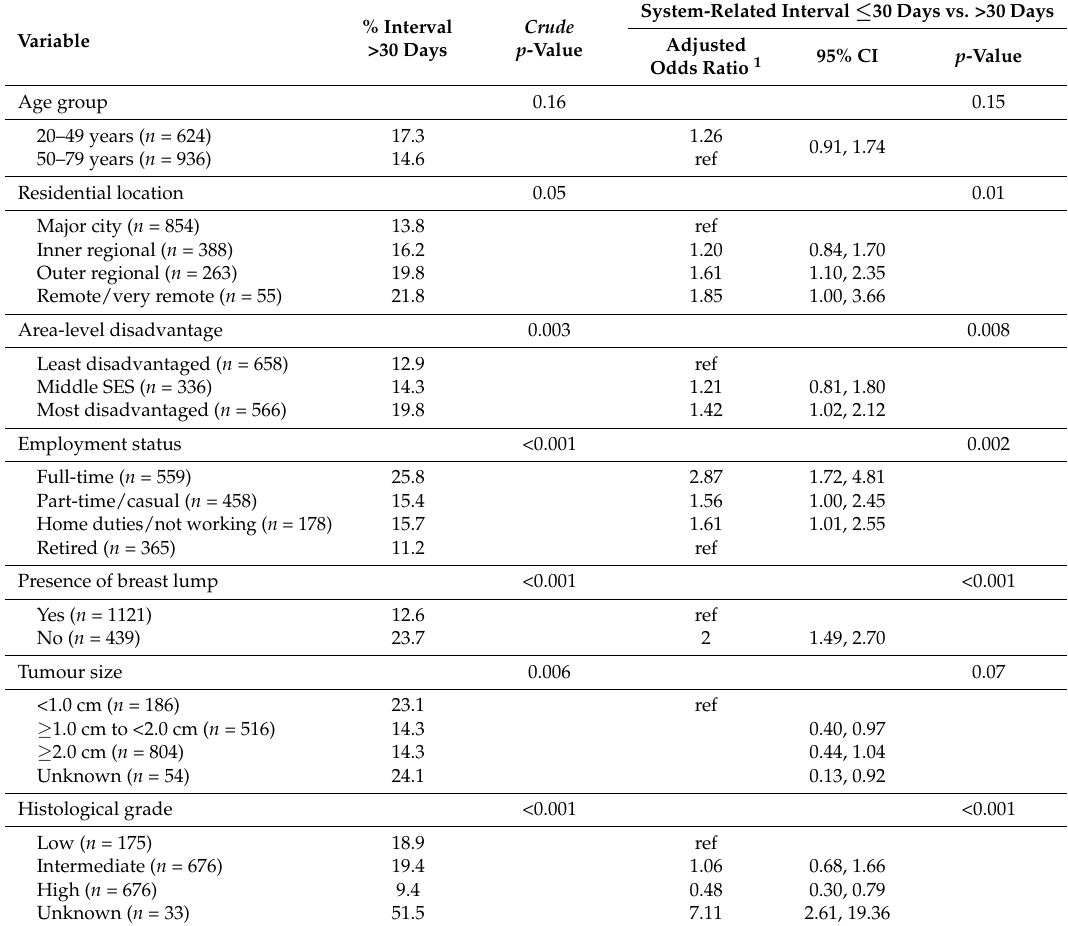
Table 3. Multivariable logistic regression model showing factors associated with system-related interval for 1560 women with symptom-detected breast